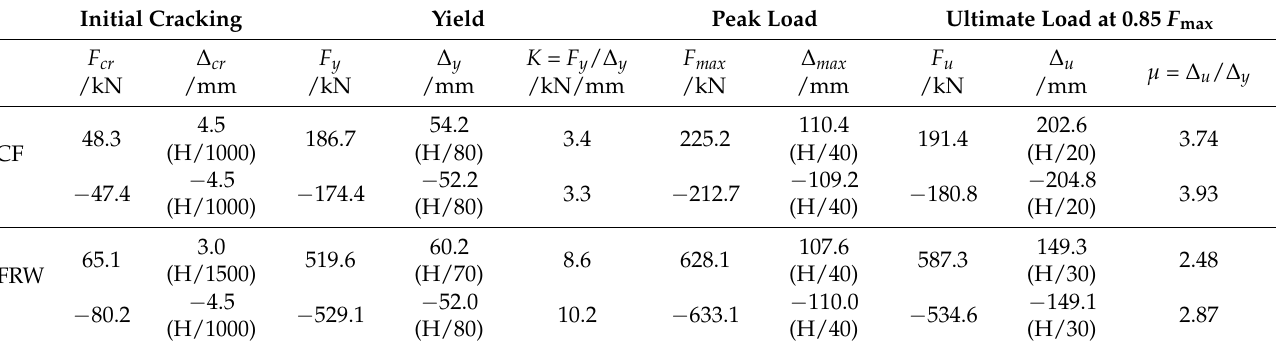
Figure 9. Backbone curves. Table 3. Key response parameters of the backbone